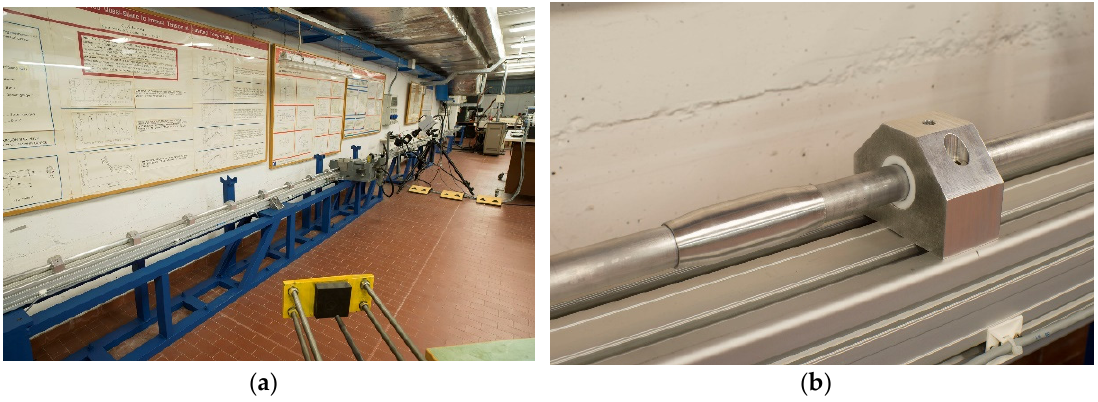
Figure 2. ( a ) MHPB ‐ SM at the ELSA of JRC; ( b ) detail of bar ‐ joint and support.